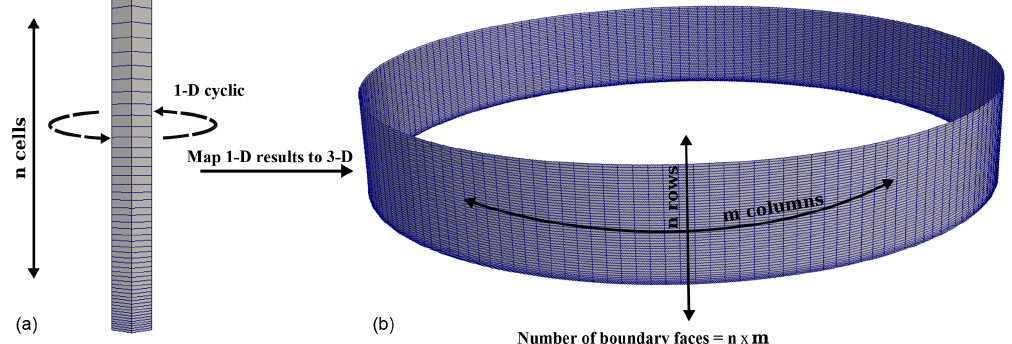
Figure 1. The inflow velocities of each cell from 1-D precursor run (a) are copied to the boundary of the 3-D domain (b) , which has a similar number of cells in the vertical direction. Ideally the height of each face in the 3-D domain boundary is exactly the same as its counterpart cell in the 1-D